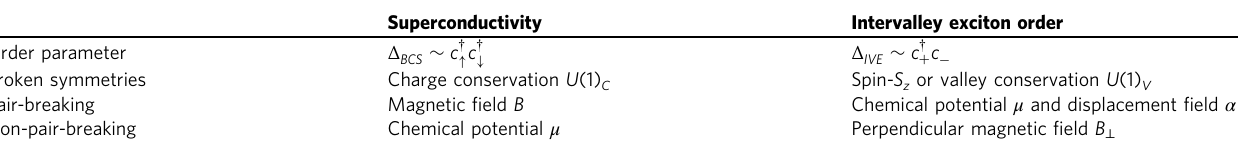
Table 1 The correspondence between intervalley exciton condensation and the BCS